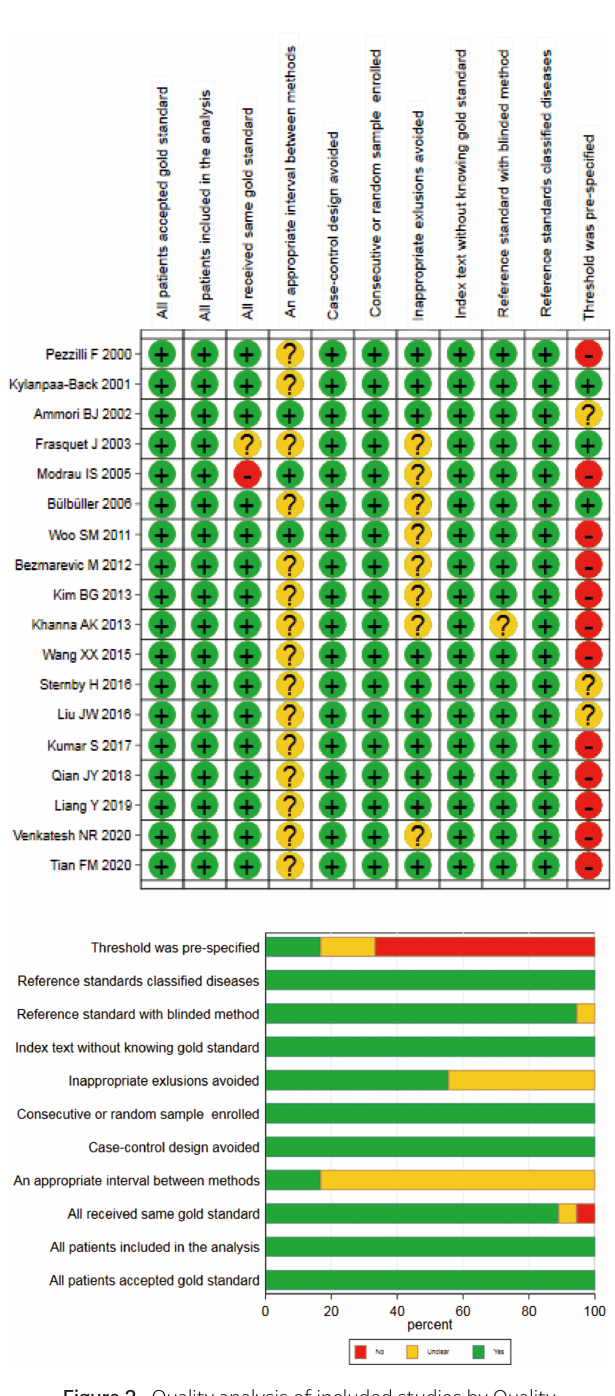
Figure 2. Quality analysis of included studies by Quality Assessment of Diagnostic Accuracy Studies-2 tool. (A) Risk of bias summary: risk of bias item for all studies. “+”: low risk of bias; “?”: unclear risk of bias; “-”: high risk of bias. (B) Risk of bias graph: risk of bias item presented as percentages among all